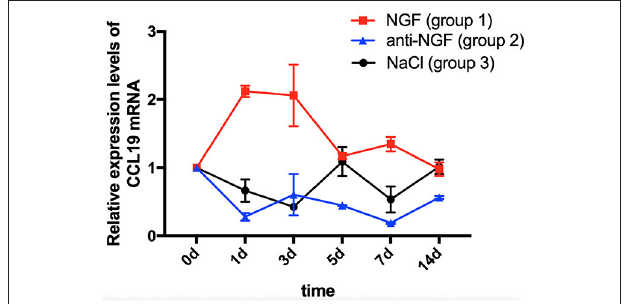
FIGURE 1 | Time course of C-C chemokine ligand 19 (CCL19) mRNA expression in rats’ TGs following the injection of nerve growth factor (NGF)-related reagents. (The statistical analysis results related to the image are shown in Table 1 ).